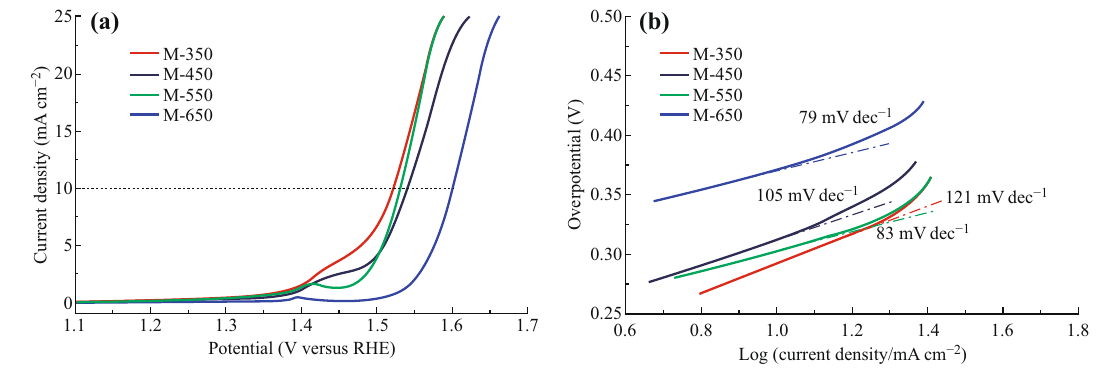
Fig. 8 a LSV curves of M-350, M-450, M-550, and M-650 in O 2 -saturated 1.0 M KOH solution (scan rate 5 mV s - 1 ), b Tafel plots of the synthesized catalysts